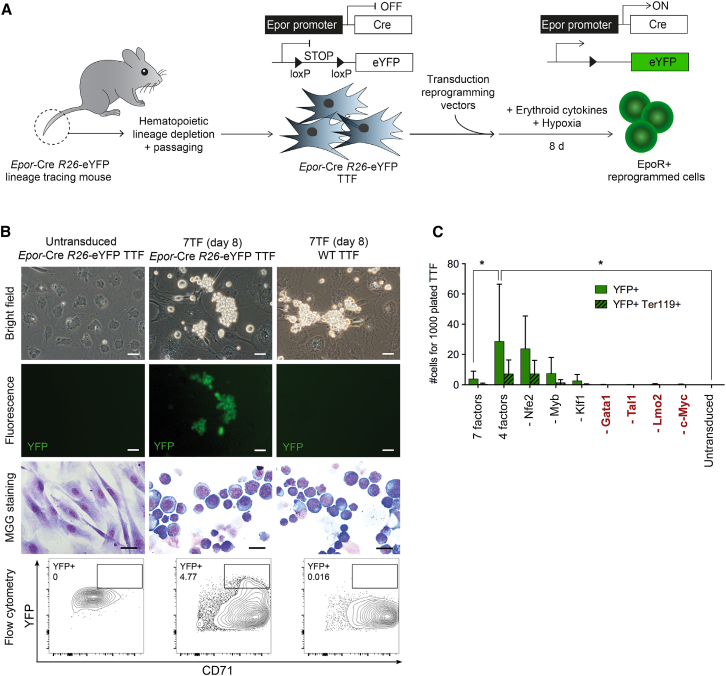
Forced Expression of Gata1, Tal1, Lmo2, and c-Myc Reprograms Murine Adult Fibroblasts into Erythroid Progenitors(A) Experimental design for transcription factor-mediated reprogramming of erythroid reporter (Epor-Cre R26-eYFP) TTFs to EpoR+ reprogrammed cells.(B) Representative live-cell, bright-field images, fluorescence images, May-Grünwald-Giemsa staining images, and flow cytometry plots of untransduced TTFs and 7TF-iEPs generated from Epor-Cre R26-eYFP TTFs and WT TTFs on day 8. Scale bars, 20 μm.(C) Numbers of YFP+ and YFP+Ter119+ total live cells after removal of individual TFs from the 7TF pool on day 8. Data are presented as mean ± SD (n = 2–3). ∗p ≤ 0.05.See also Figure S1.